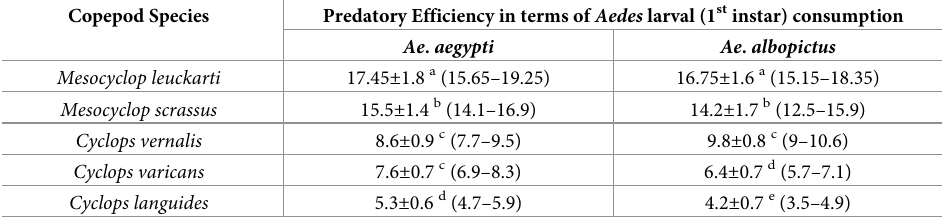
Note: Values are Mean ± SE, range in parenthesis. Different superscript letters (from a to e) in a column show significant differences (p < 0.05) as suggested by General Linear Modelling followed by the Tukey’s pair wise comparison at 95% level of significance.